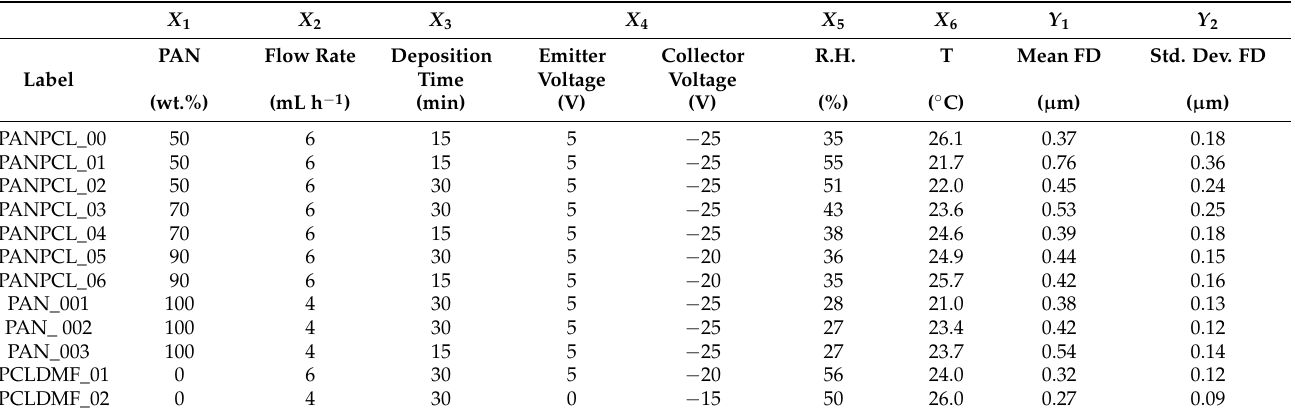
Table 1. Complete table matrix of seven process parameters and environmental variables ( Xi ) and two output variables ( Yi